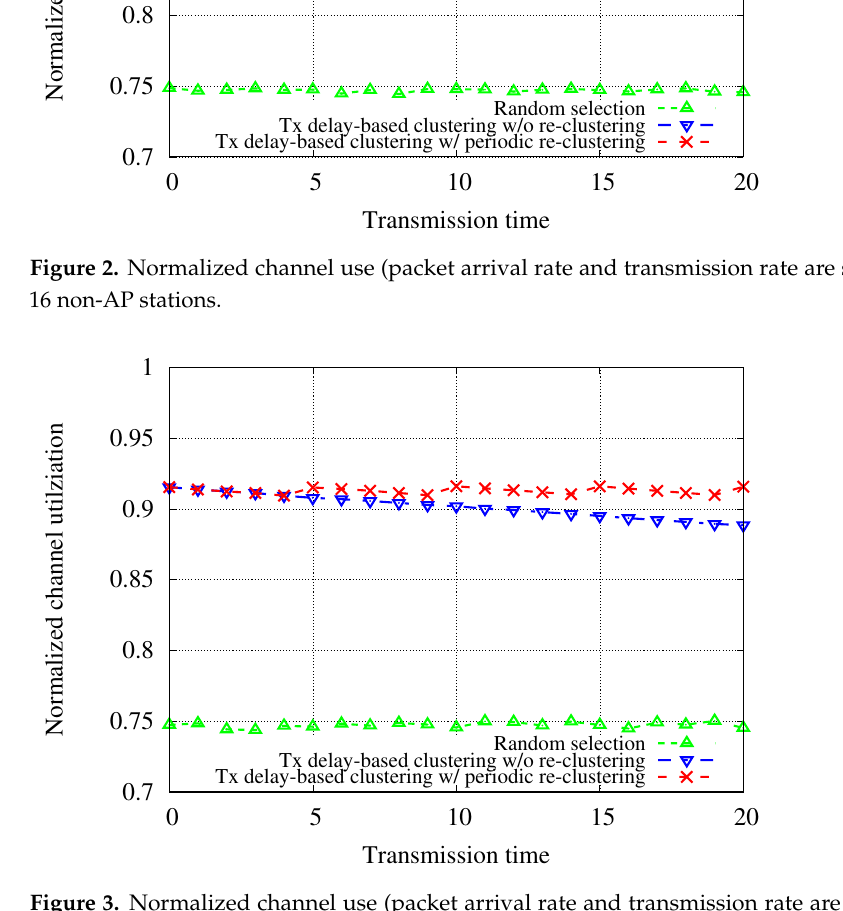
Figure 3. Normalized channel use (packet arrival rate and transmission rate are same. There are 24 non-AP